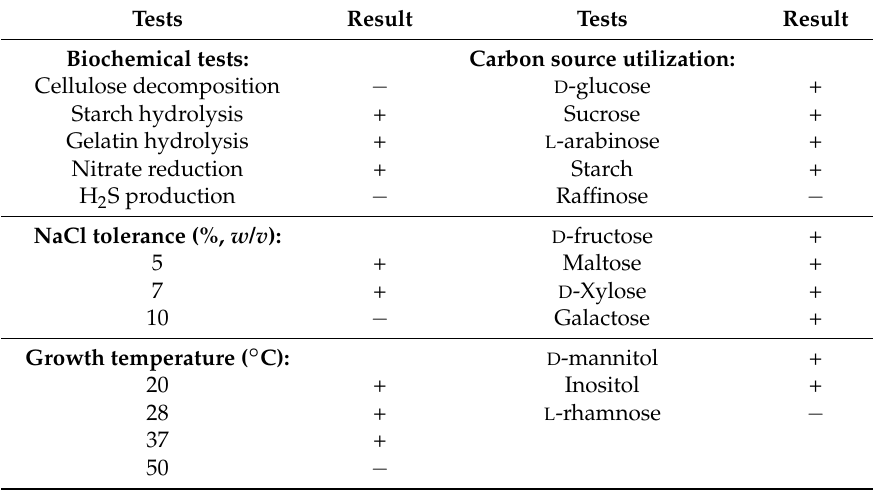
Table 1. Physiological and biochemical characteristics of the strain